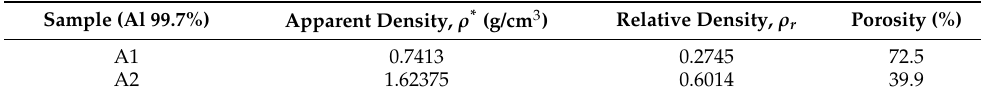
Table 1. Structural properties of the aluminium foam samples.